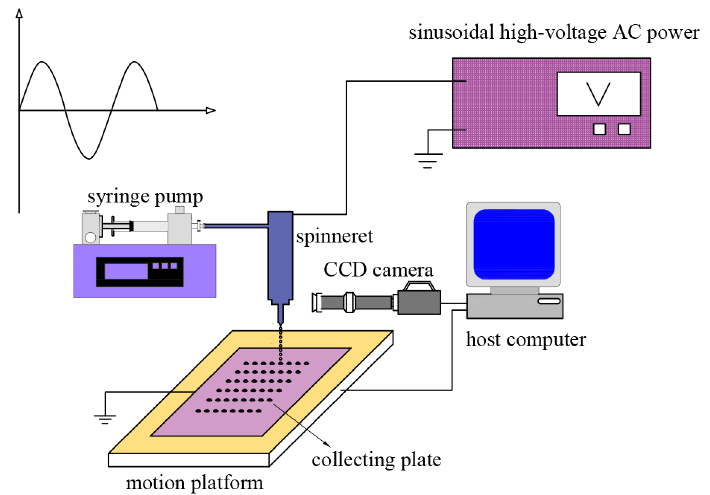
Figure 1. Alternating current (AC) electrohydrodynamic direct-write experimental system.